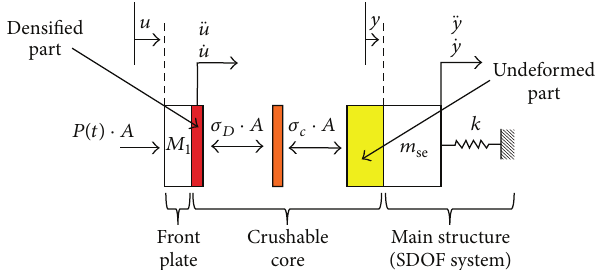
Figure3:Simplifiedinteractionbetweenthesacrificialcladdingand the main structure given by Ma and Ye